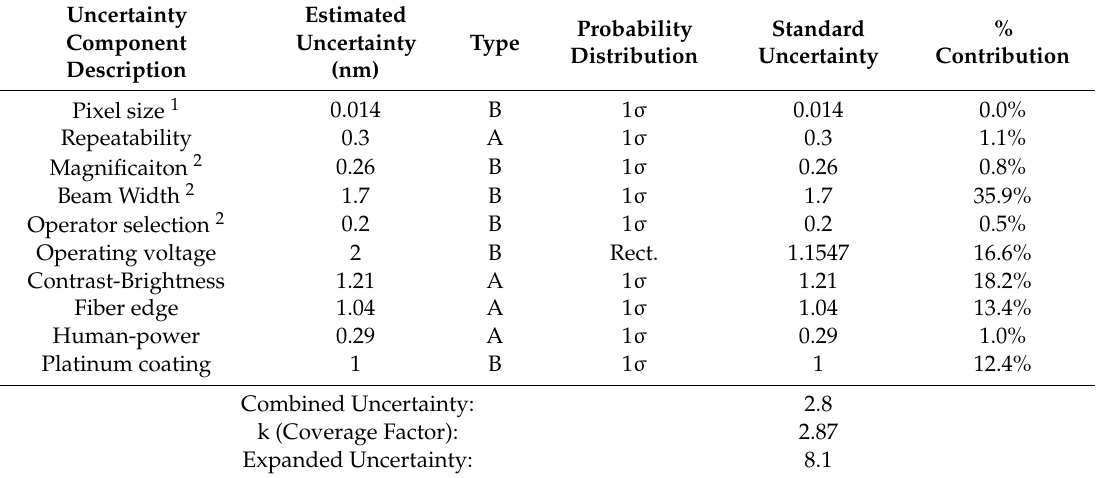
Table A2. Uncertainty budget for measured values presented in relation to Figure A12.